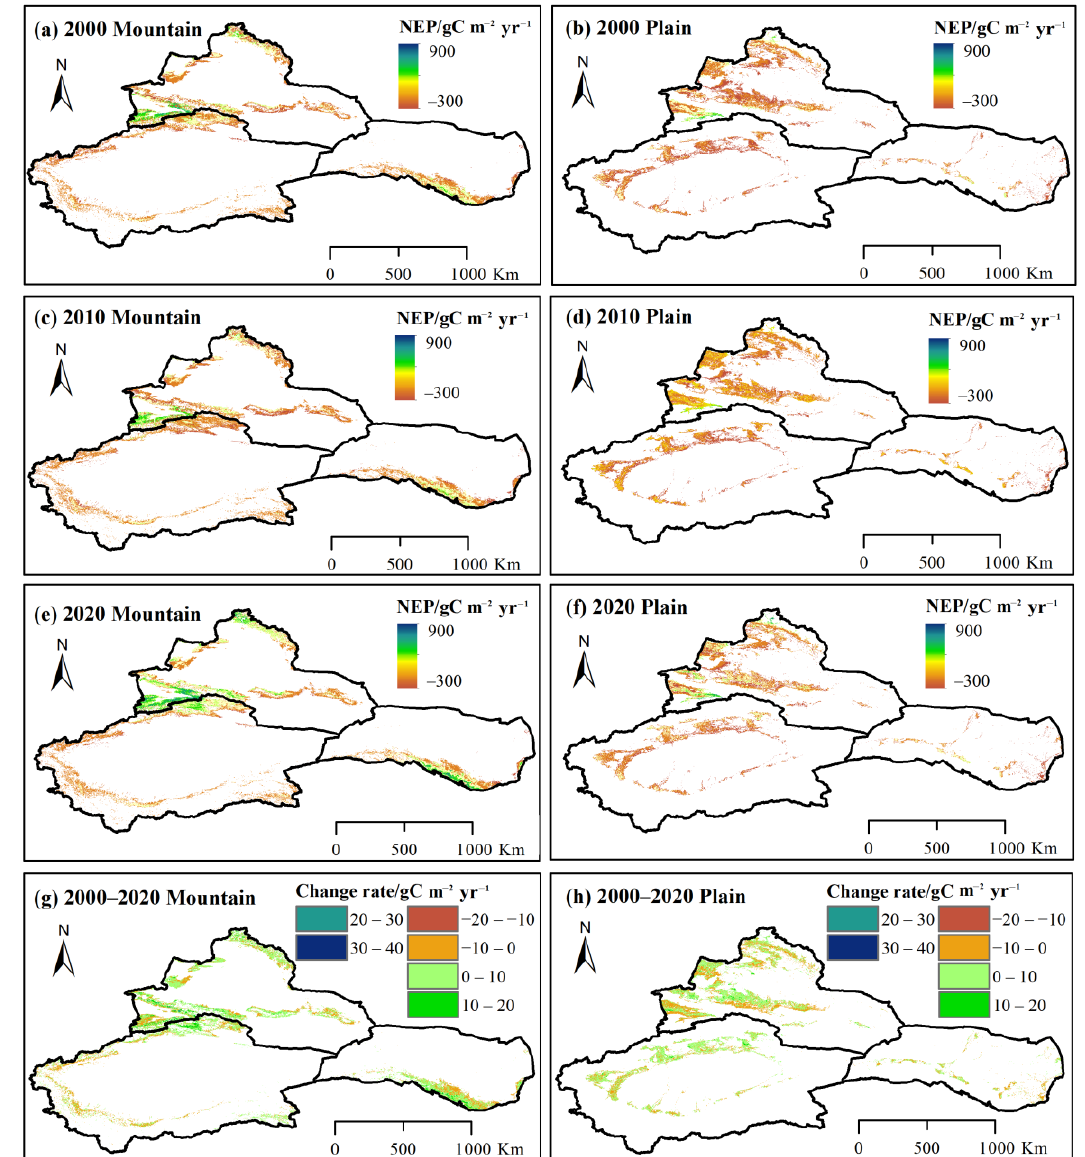
Figure 6. Spatial distribution and variations of vegetation NEP in mountain and plain during 2000−2020. Spatial distribution of NEP in the mountain and plain during ( a , b ) 2000, ( c , d ) 2010, and ( e , f ) 2020; ( g , h ) spatial variations of NEP in mountain and plain during 2000−2020.